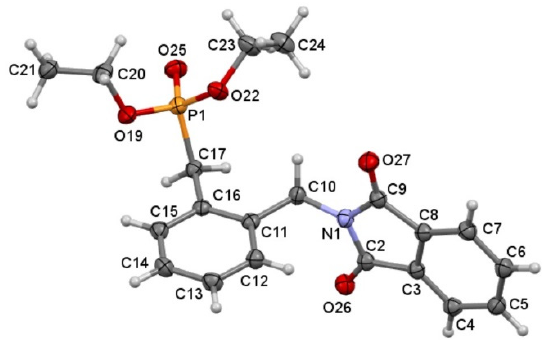
Figure 3. Molecular structure of 7a with atom-labeling scheme.